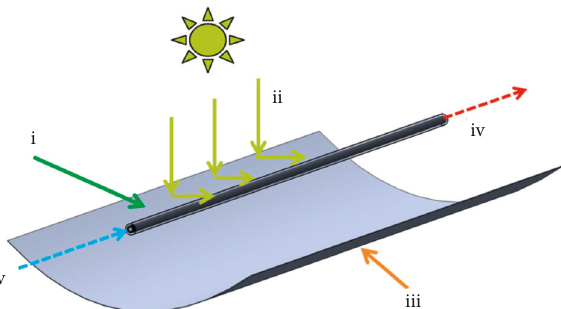
Figure 1: Representation of a PTSC: (i) absorber tube, (ii) solar rays, (iii) parabolic trough, (iv) fluid outlet temperature, and (v) fluid inlet temperature